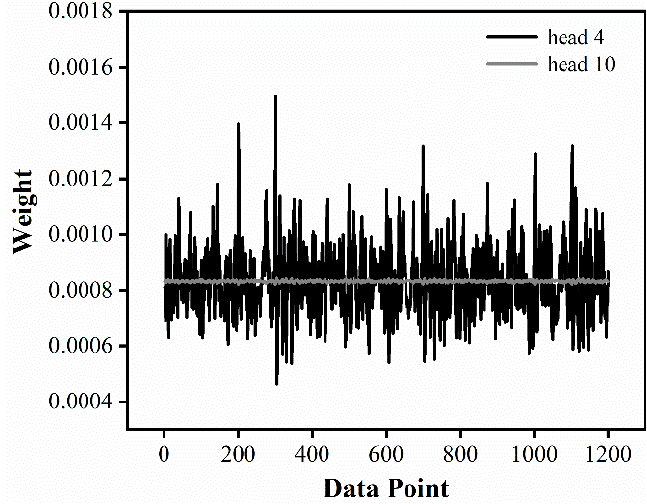
Figure 11. First layer attention weight results discounted graph.